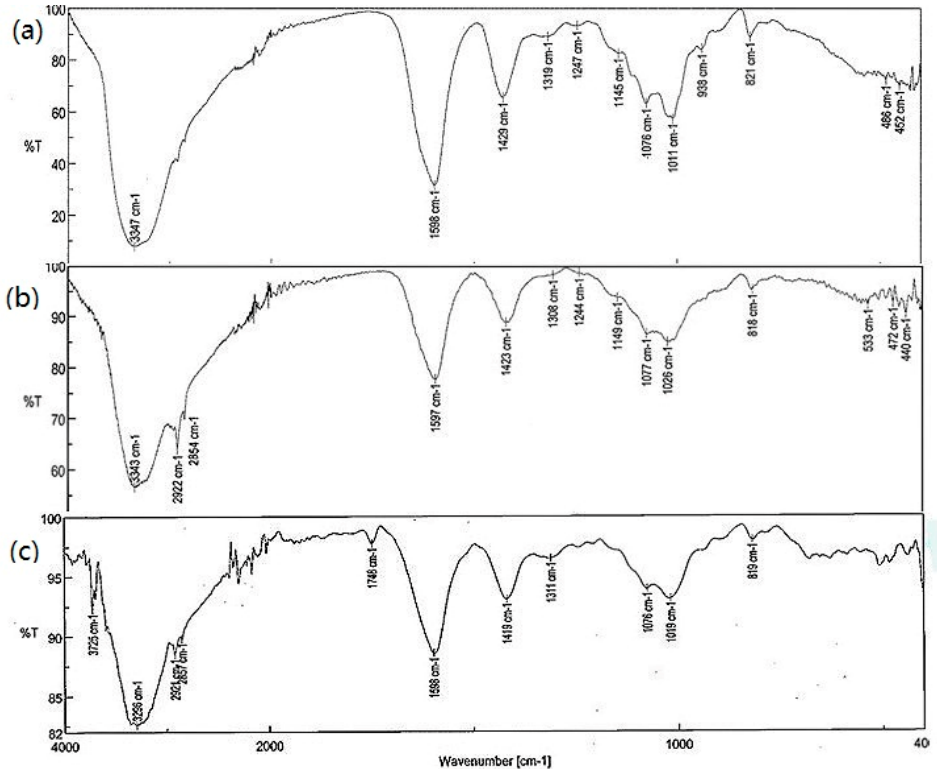
Figure 8. FTIR spectra of alginate capsules without and with the gemini surfactants: ( a ) Al@empty; ( b ) Al@12-O-12; ( c ) Al@10(E)-O-10(E) Cl.